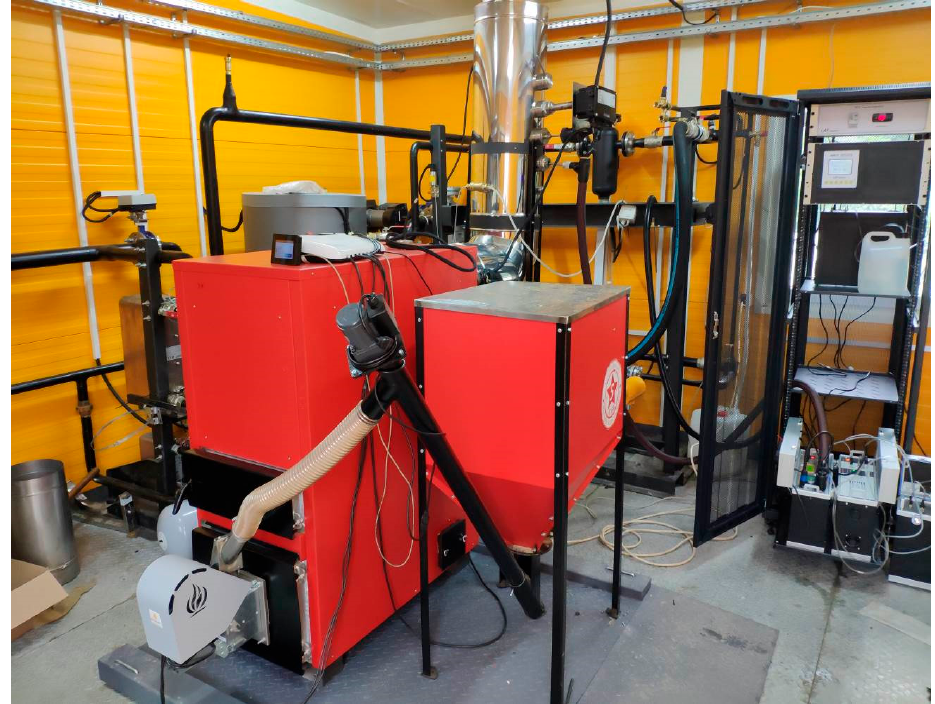
Figure 3. Tested boiler on the testing stand.